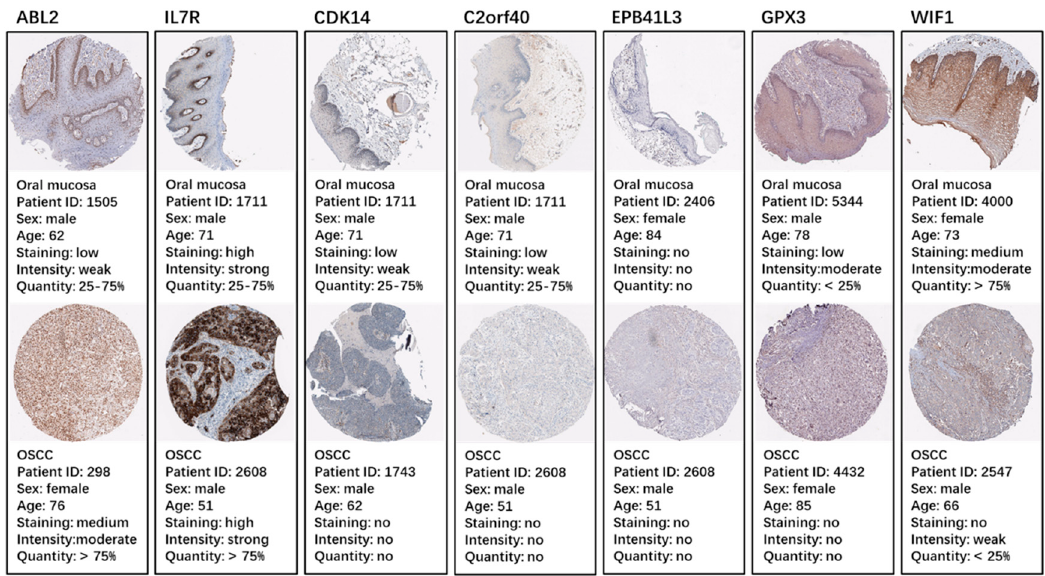
Figure 6. Validation of the seven genes on a translational level using the Human Protein Atlas database (IHC: immunohistochemistry).